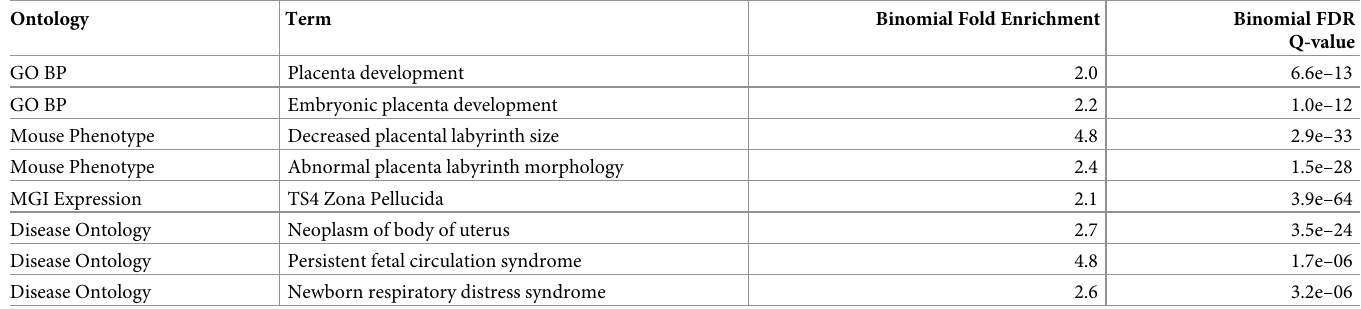
Table 2. Placenta-relevant functions significantly enriched among genes near high-confidence predicted placental enhancers. GO BP = Gene Ontology Biological Process.